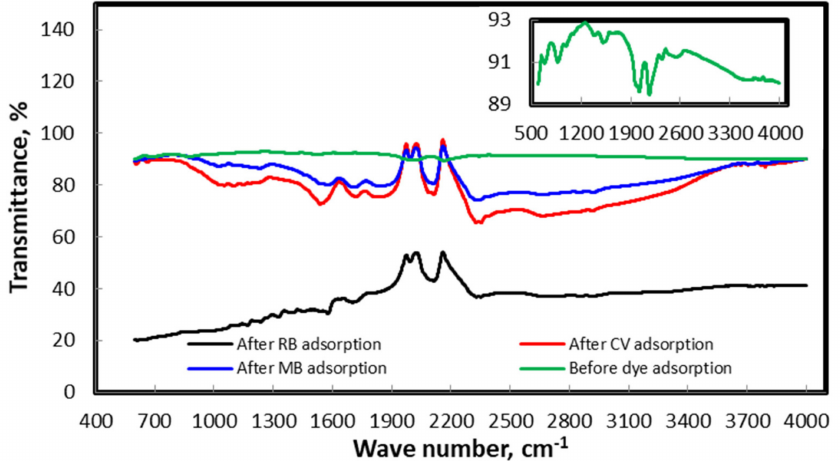
Figure 3. FT-IR spectra of SPE extraction sorbent material before and after extraction process. Inset: FT-IR spectrum of pristine SPE sorbent.